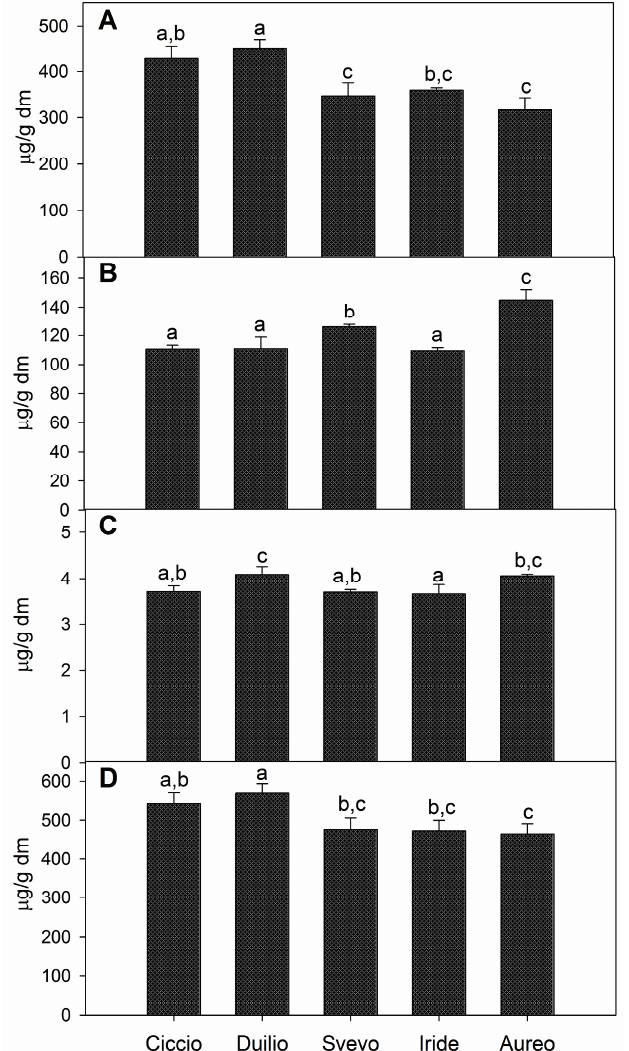
Figure 1. Content of total bound ( A ); total conjugated ( B ); total free phenolic acids ( C ); and total phenolic acids ( D ) as the sum of bound, conjugated and free phenolic acids, expressed as μ g/g dm, in the whole meal flour of five, Italian, durum wheat cultivars. Different letters within each panel indicate significant differences between samples ( n = 3, p <